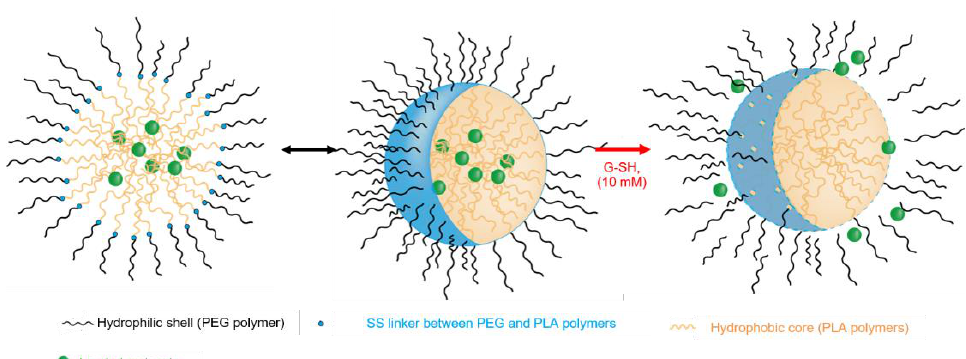
Figure 5. Schematic representation of release of the encapsulated molecule from the mPEG-SS- PLA/PLA core–shell nanocarriers.